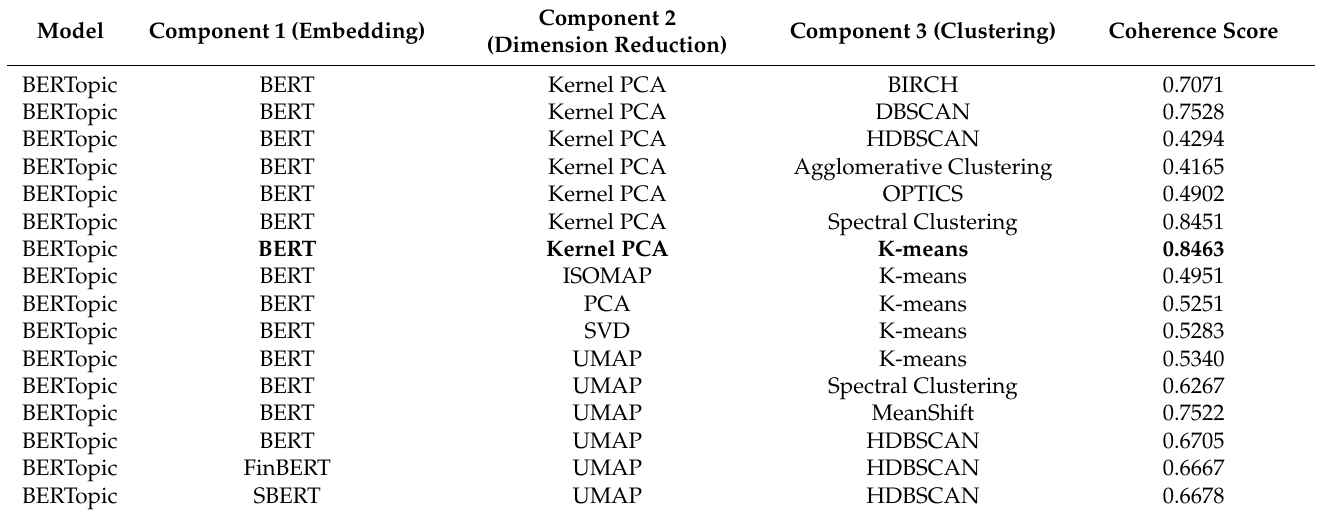
Table 7. BERTopic coherence score.